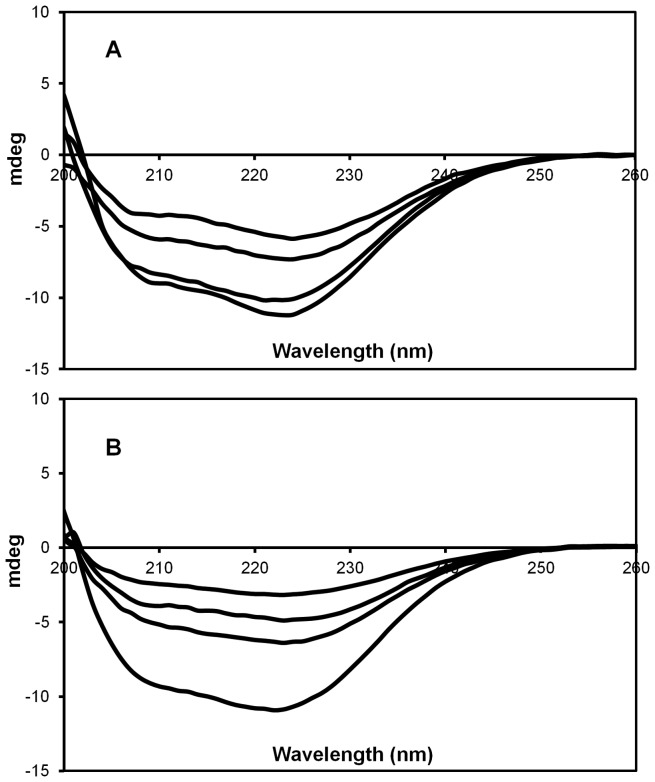
Effect of ribosylation on the CD activity of the W7FW17F apomyoglobin.Time dependence of the far-UV CD activity of the amyloid forming W7FW14F apomyoglobin mutant at pH 7.0 in the absence (A) and in the presence of 0.5 M D-ribose (B). From the lower to the upper spectrum, times are: 1, 60, 180, and 360 min. Protein concentration was 20 µM.